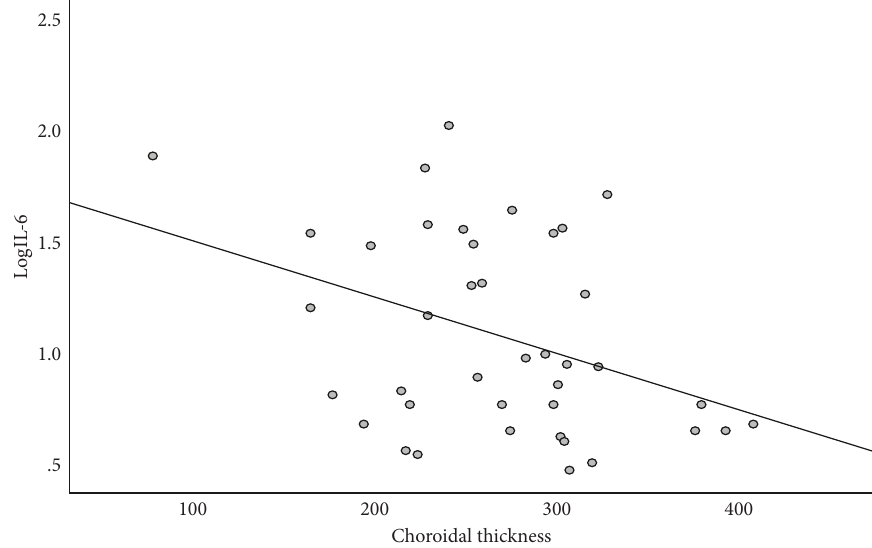
Figure 2: Relationship between aqueous humor IL-6 and CT in DME patients.